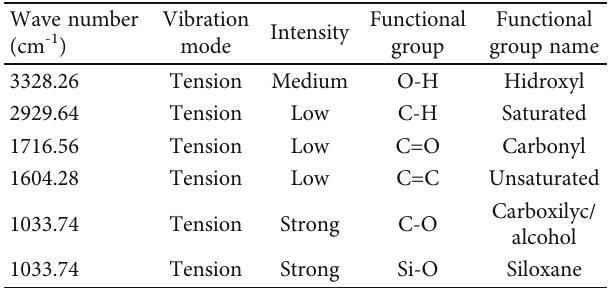
Table 1: Main functional groups present in untreated rice husk